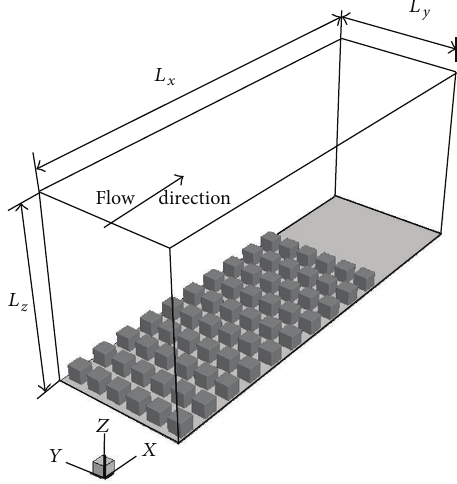
Figure 1: Three-dimensional schematic of numerical model.